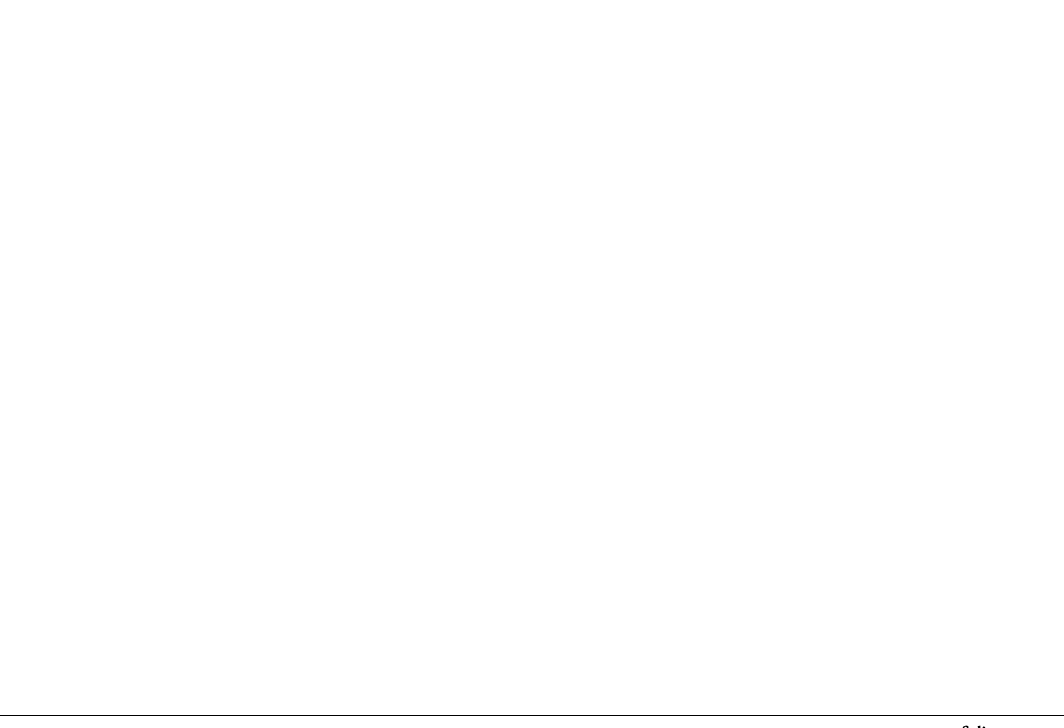
Figure 10. Test problems: Rosenbrock10